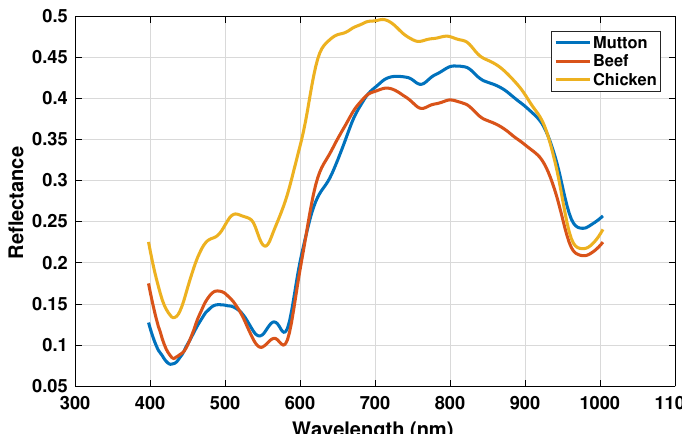
Figure 2. Mean reflectance spectrum for beef, mutton and chicken minced meat.